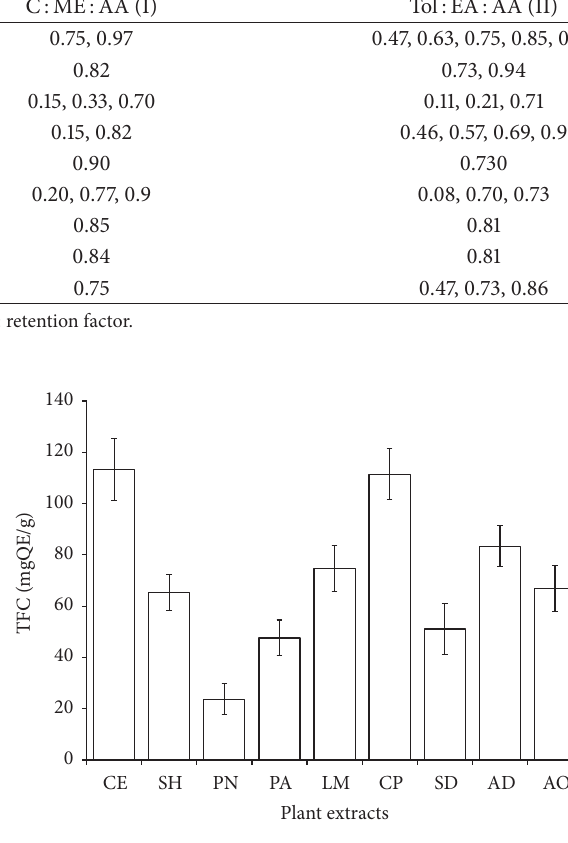
Figure 2: Total flavonoids content (TFC) of selected antidiabetic plants used in southeast Nigeria. CE, Chlorophora excelsa ; CP, Ceiba pentandra ; SH, Strophanthus hispidus ; SD, Synsepalum dulcificum ; PN, Picralima nitida ; AD, Anthocleista djalonensis ; PA, Persea americana ; AO, Anacardium occidentale; LM, Loranthus micranthus ; QE, Quercetin